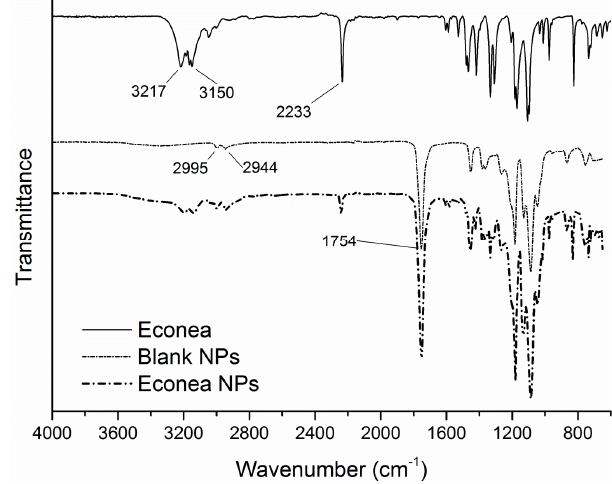
Figure 5. FTIR-ATR spectrum of Econea NPs and comparison spectra.